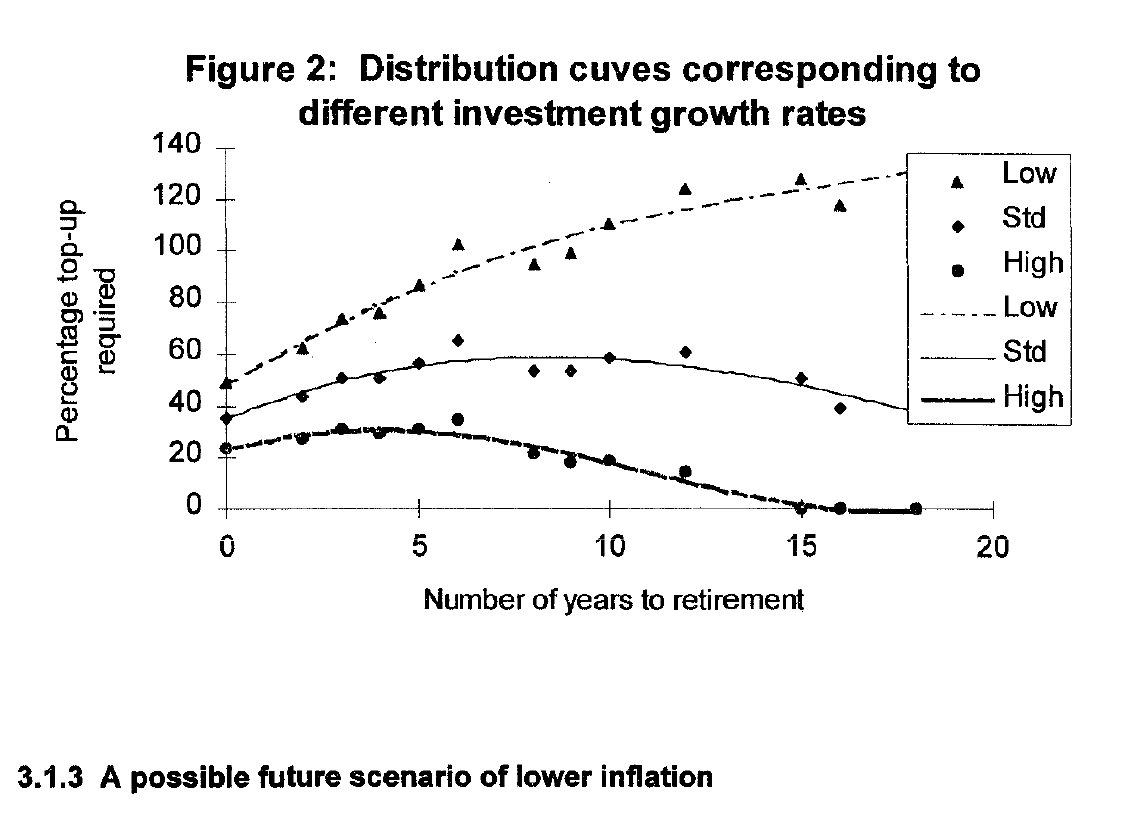
Figure 2: Distribution cuves corresponding